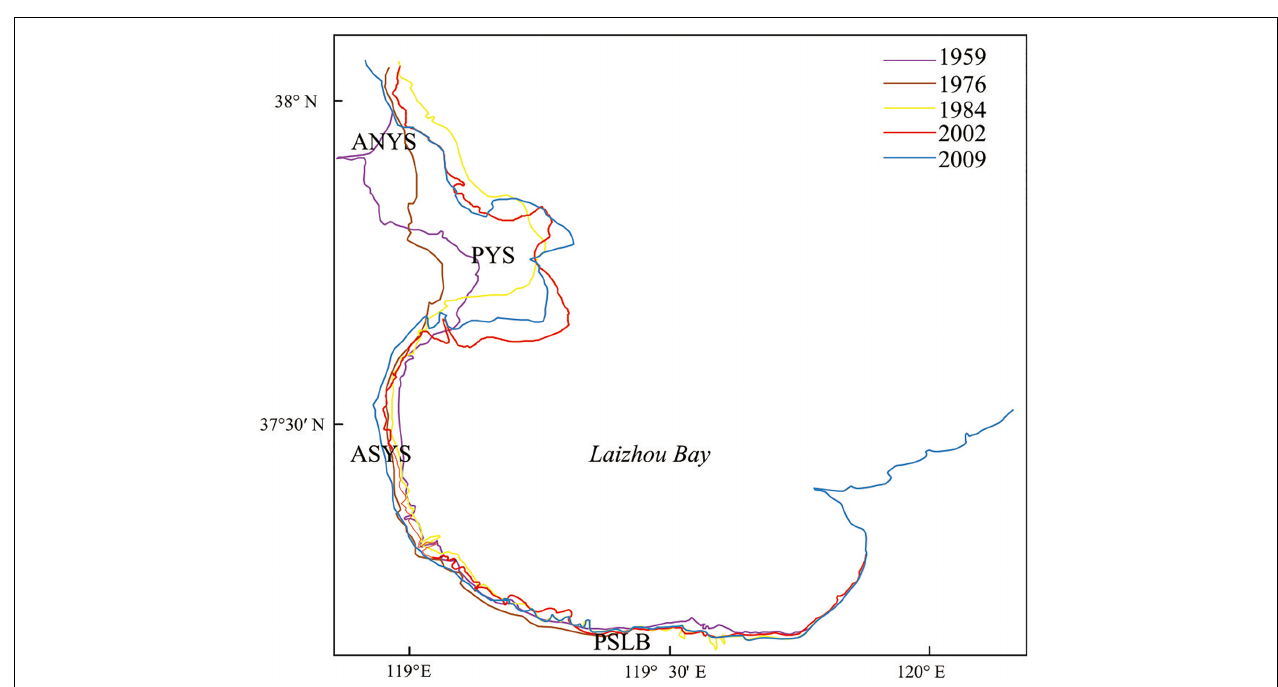
FIGURE 7 | The coastline evolution of the southern abandoned sub-delta and adjacent zones. The figure is drawn with the help of GIS tools based on nautical charts measured in 1959, 1976, 1984, 2002, and 2009.